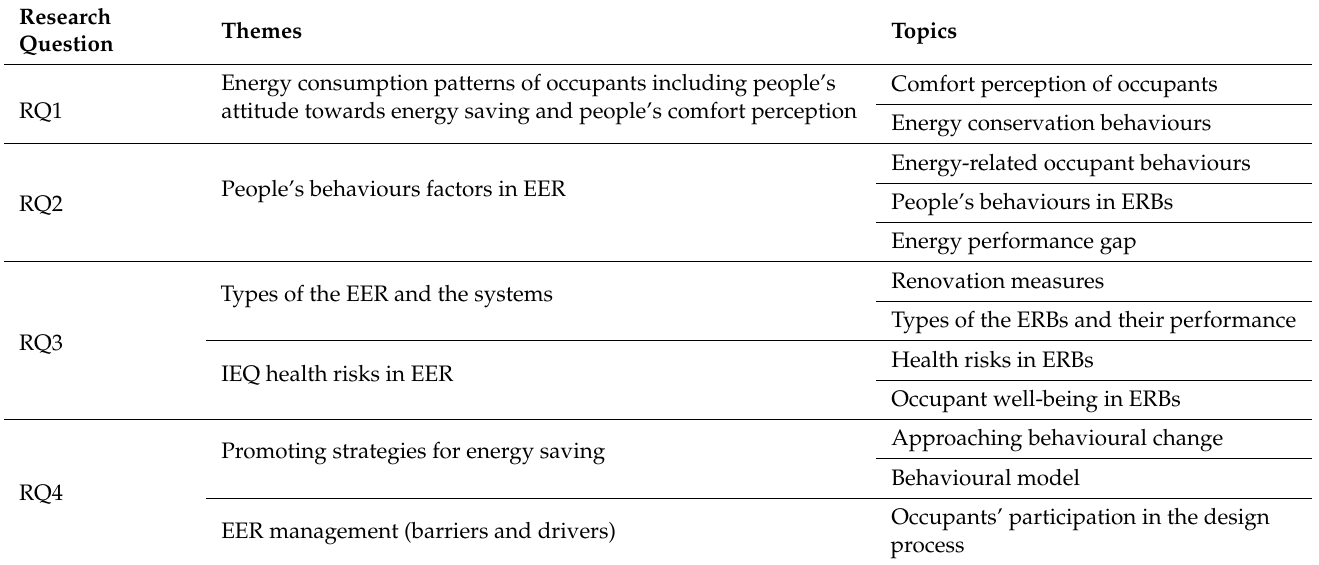
Table 1. The relation of research questions to the themes and